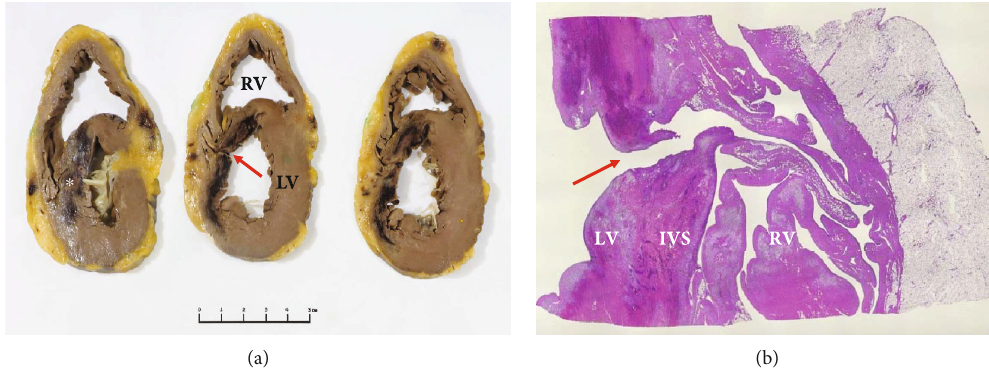
Figure 3: Explanted heart showing. (a) Cross-section through the basal (left) to apical (right) left ventricle (LV) demonstrating haemorrhagic infarct involving the interventricular septum (IVS) and anterior LV (asterisk). A defect is evident through the infarcted region of the IVS (arrow). (b) At low power, a full thickness defect is evident through the region of infarction (arrow), allowing communication from LV to RV, via a tortuous path.